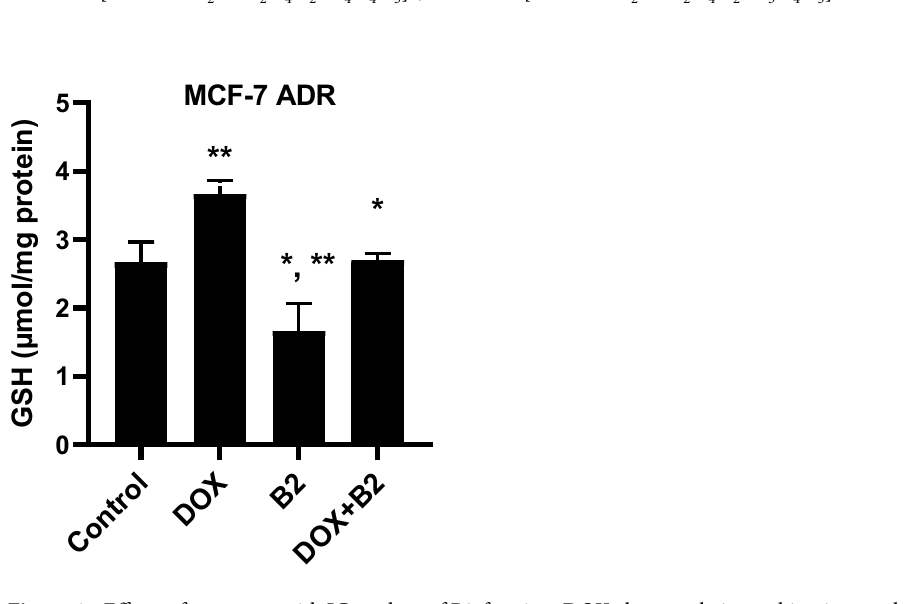
Figure 4. Effects of treatment with IC 50 values of B2-fraction, DOX alone or their combination on the intracellular level of GSH within MCF-7 ADR cells. Data are presented as mean ± SD; n = 3. *Significantly different from DOX treatment. **Significantly different from